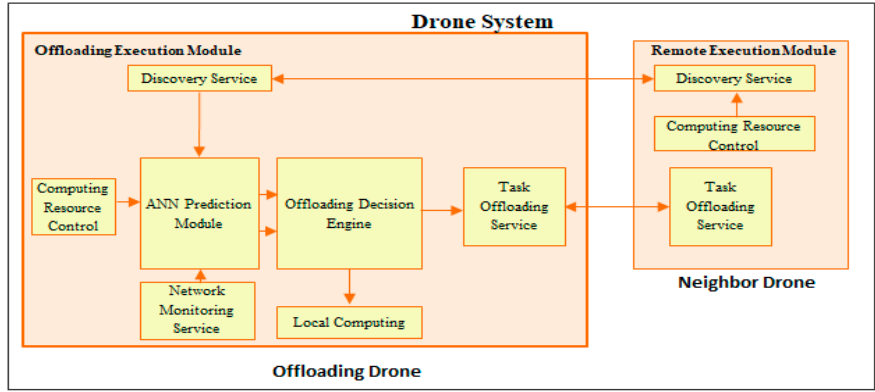
Figure 2. Artificial neural network (ANN)-based opportunistic computation offloading system architecture.